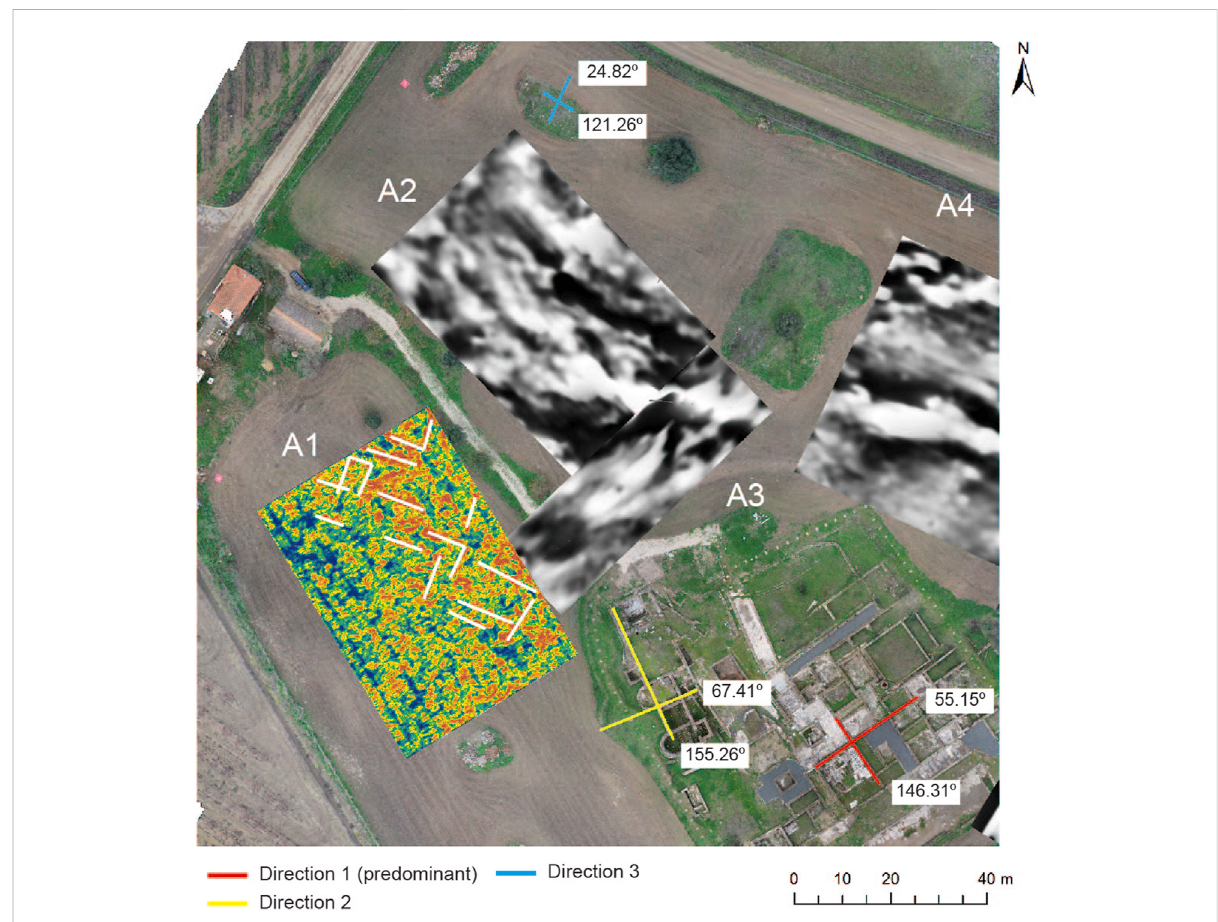
FIGURE 16 Interpretation of the anomaly alignments of the fused dataset regarding the direction of the excavated structures. The fused alignments had correspondencewith thedirection 3,different pars urbana directions,andthebaths. This could indicatethelocation ofthesupport structures ofthe main part of the Roman Villa that have not yet been